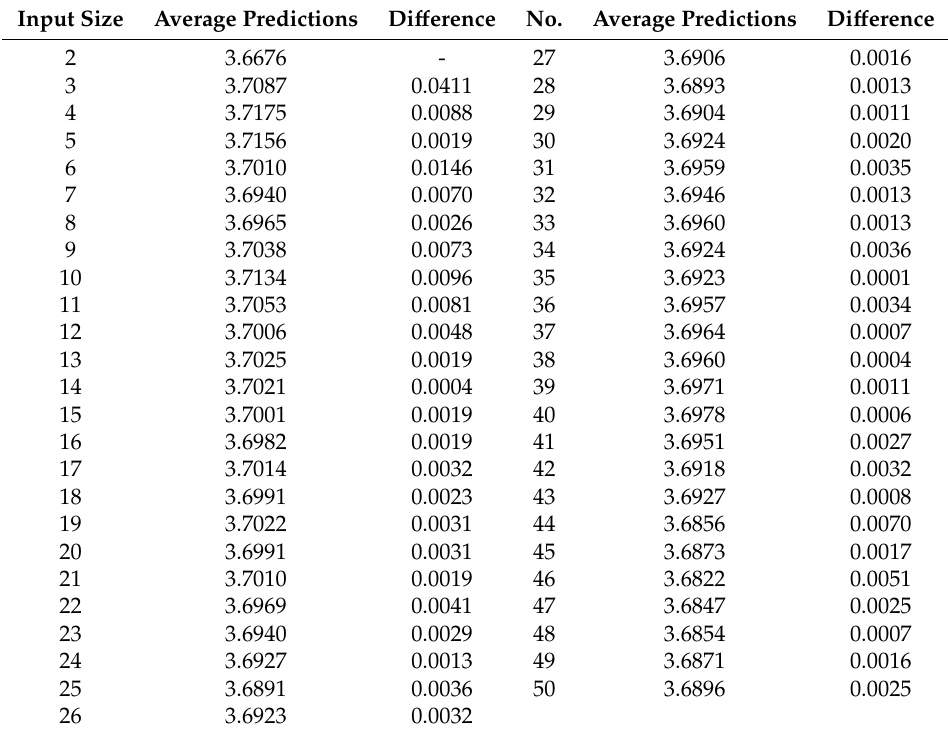
Table 5. Changing average of prediction and di ff erence for each range (the user-based filtering: the Pearson correlation coe ffi